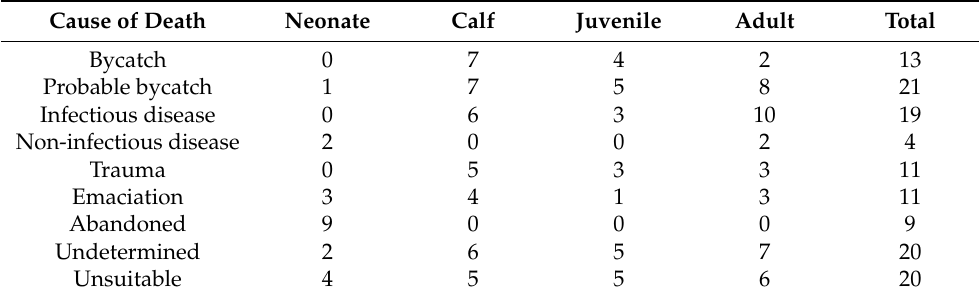
Table 2. Causes of death of stranded harbour porpoises ( Phocoena phocoena ) collected from Swedish waters from 2006 to